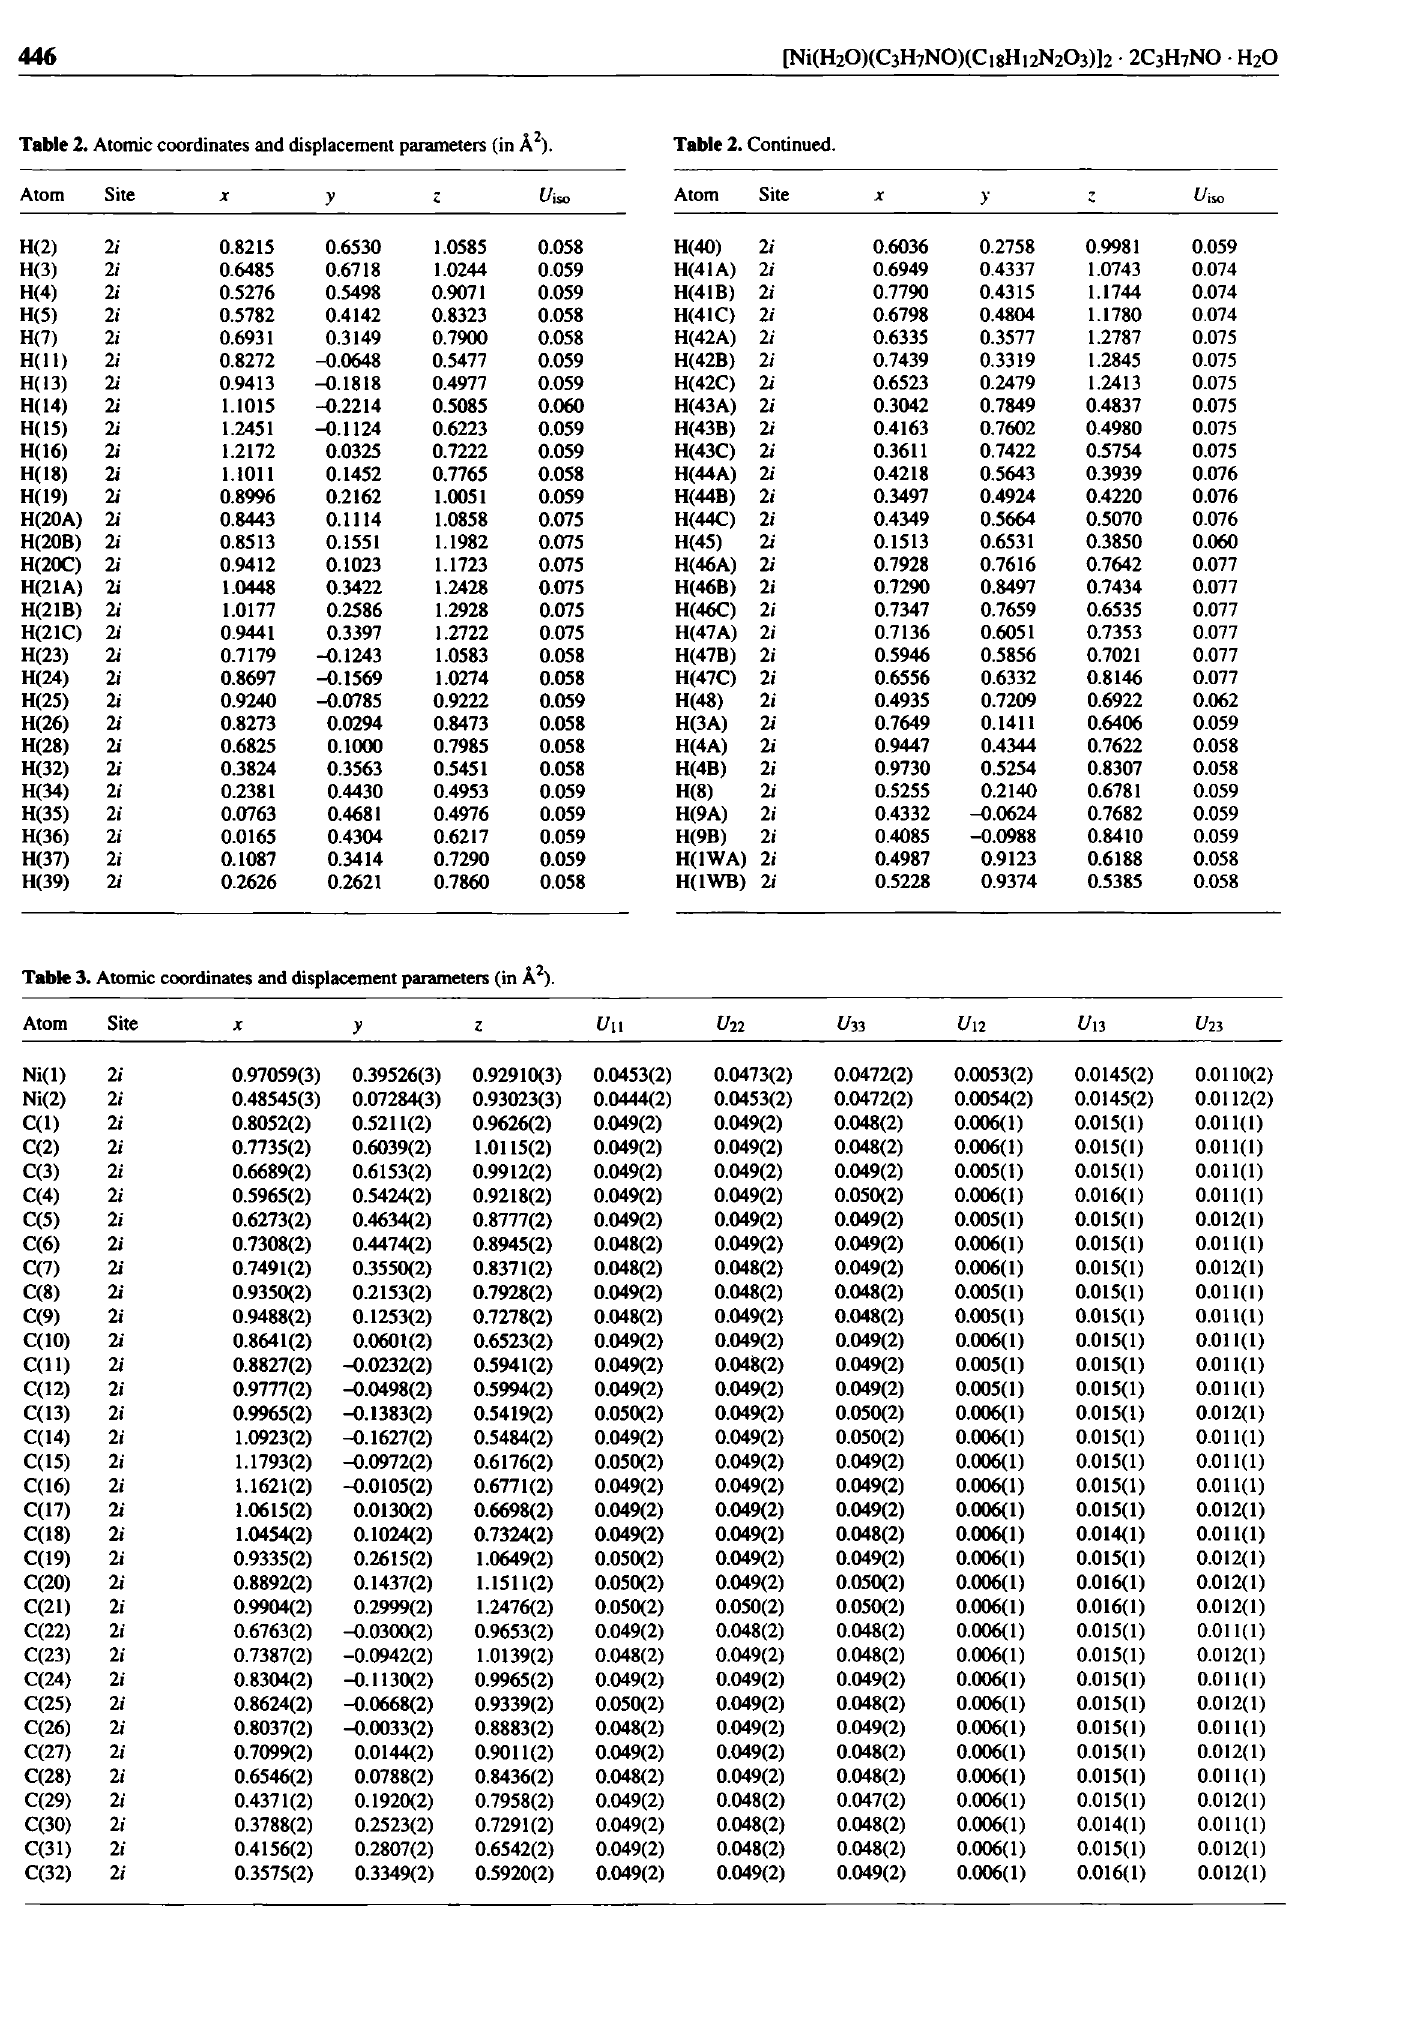
Table 3. Atomic coordinates and displacement parameters (in À 2